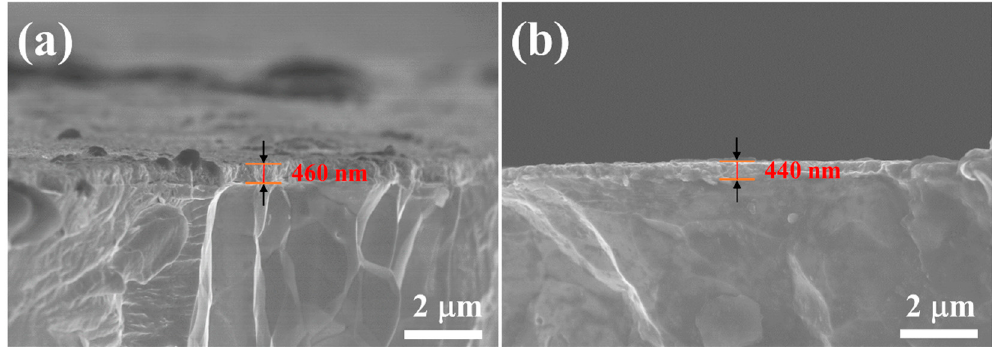
Figure 3. Cross-sectional SEM of ( a ) tungsten oxide formed before the reduction annealing process, and ( b ) nano-treated W structure after reduction annealing.